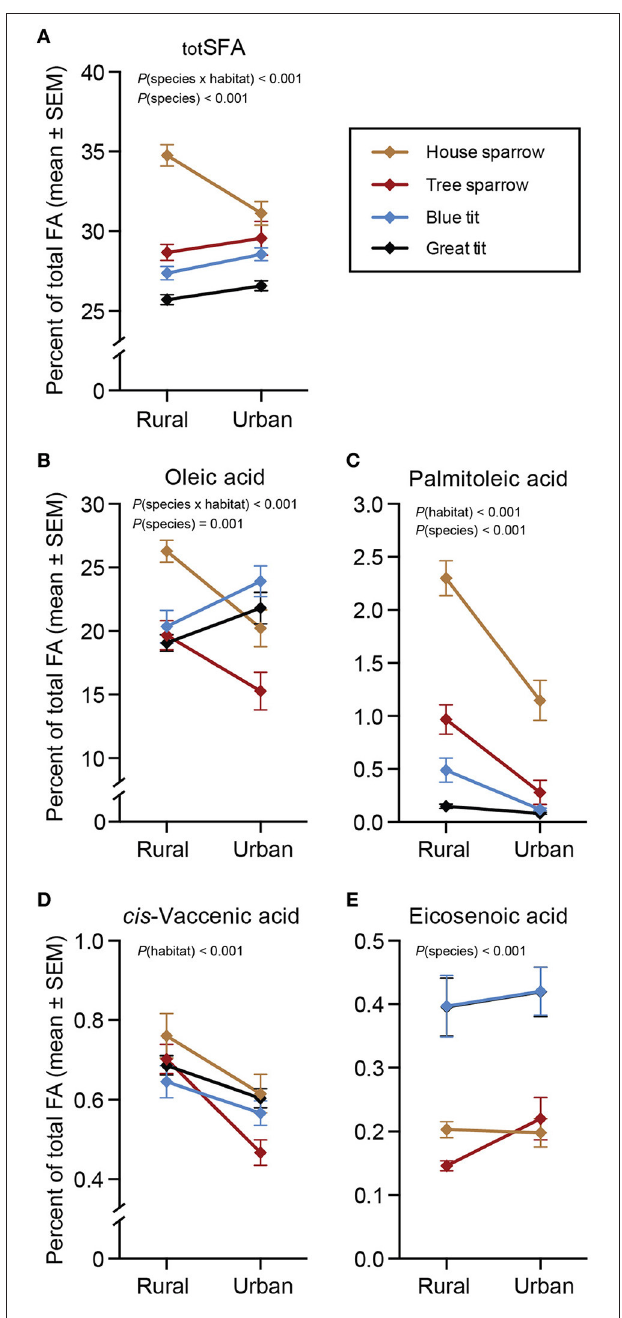
FIGURE 1 | Plasma saturated- and monounsaturated fatty acids (%) in four species of passerines from urban and rural environments. (A) Total saturated fatty acids ( tot SFA), (B–E) four monounsaturated fatty acids (MUFA). Data are presented as means ± standard error of the means (SEM). Note the different scales on the y -axes. Significant effects of species, habitat and/or the habitat × species interaction are indicated by the P- values. For n -values